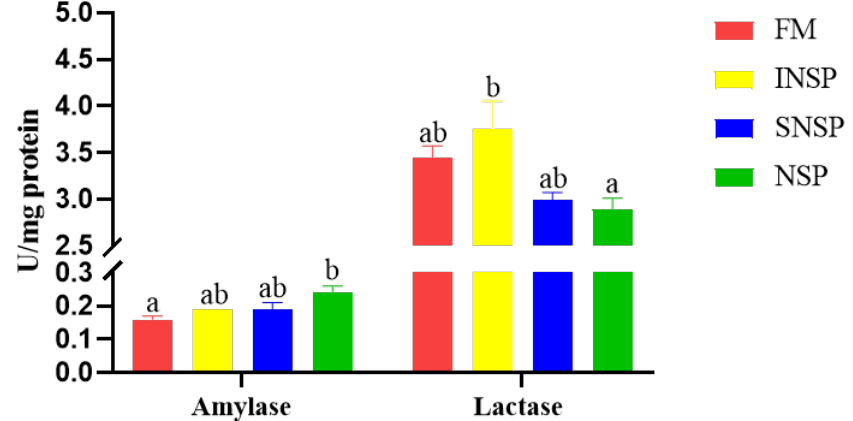
Figure 1. Intestinal amylase and lactase activities of grass carp fed with experimental diets. Values with different superscripts in each column present a significant difference ( p < 0.05; n = 3).